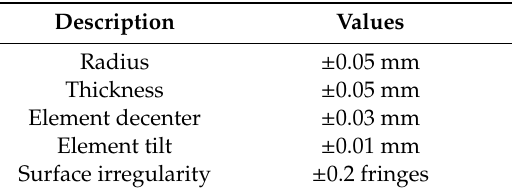
Table 2. Tolerances of the mirror-based objective.